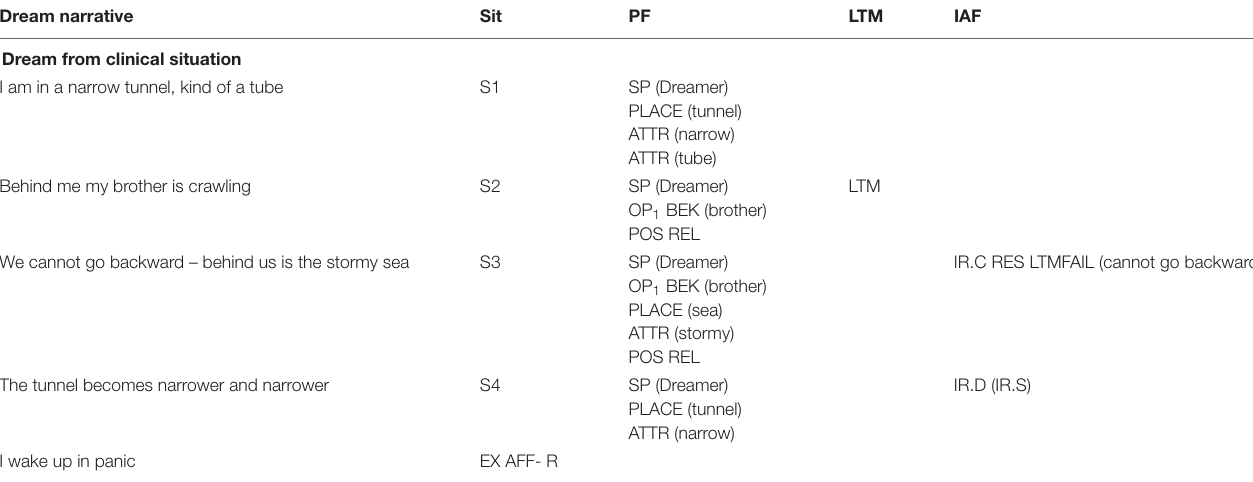
TABLE 1 | ZDPCS dream coding a clinical dream of the first 6 months of psychoanalysis. Dream